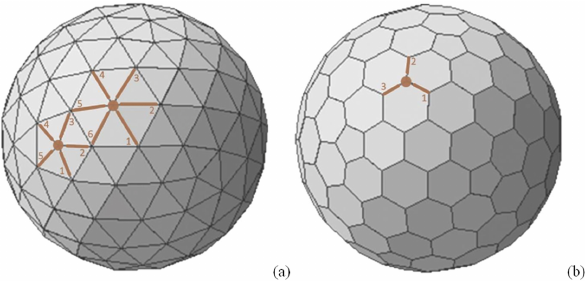
Figure 10: Geodetic dome (a); and dual fullerene polyhedron (b)